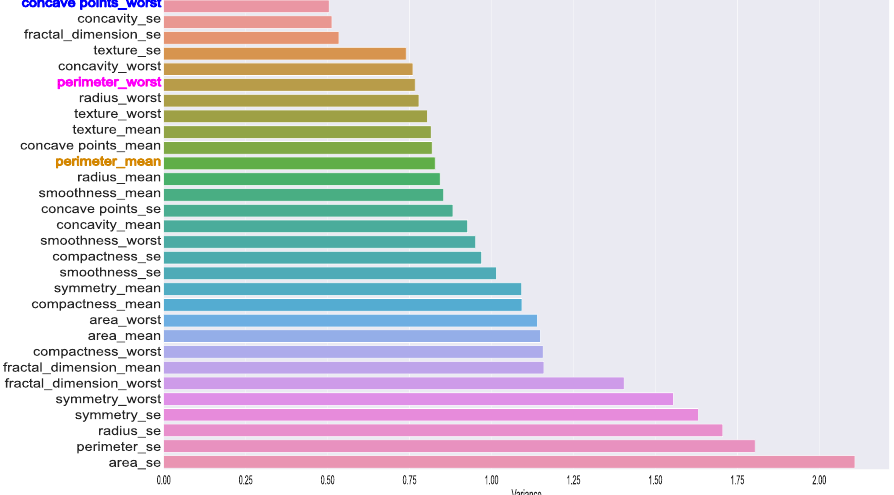
Figure 8. Feature ranking based on variance reduction per class w.r.t DL predictor’s labels ( ˆ y ). Features on the top of the figure present the highest variance reduction per class. Highlighted in bold blue is the feature concave _ point _ worst overlapping term between DEXiRE’s and ECLAIRE rule sets. Highlighted in bold magenta is the perimeter _ worst feature present in ECLAIRE’s rule set, and highlighted in bold orange is the perimeter _ mean feature present in DEXiRE’s rule